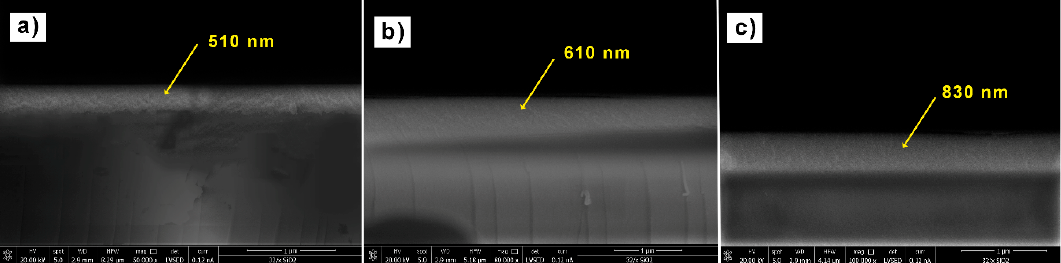
Figure 3. SEM micrographs of SiO 2 films profiles on Si substrates: ( a ) Sample P1, ( b ) sample P2, ( c ) sample P3.